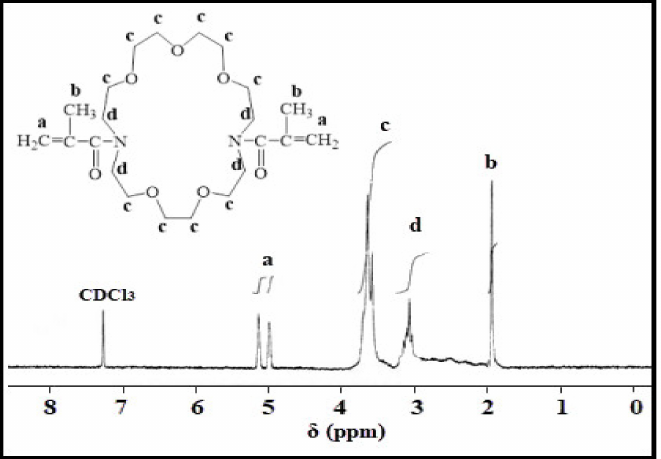
Figure 2. 1 H NMR spectrum of Kry23-DM cross-linker (in CDCl 3 ).